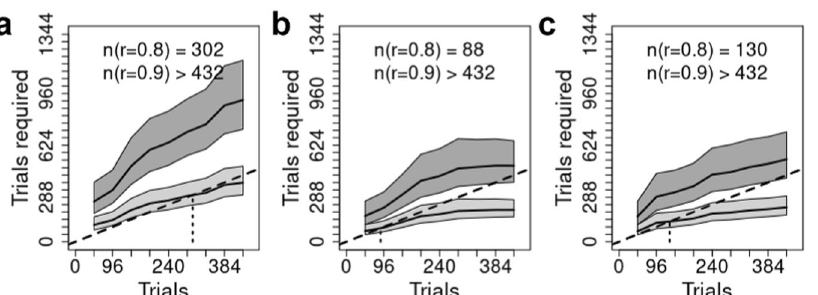
Fig. 5 | Trials required for reliable results. The total number of trials to achieve reliabilities ( r ) of 0.8 (lower line, light gray band) and 0.9 (upper line, dark gray band).Graybandsrepresenttheposteriormedian95%credibleintervals.Forevery point on the x-axis we are predicting the number of trials required to achieve a reliabilityof0.8(lightgrayregion)or0.9(darkgrayregion);thedottedverticalline